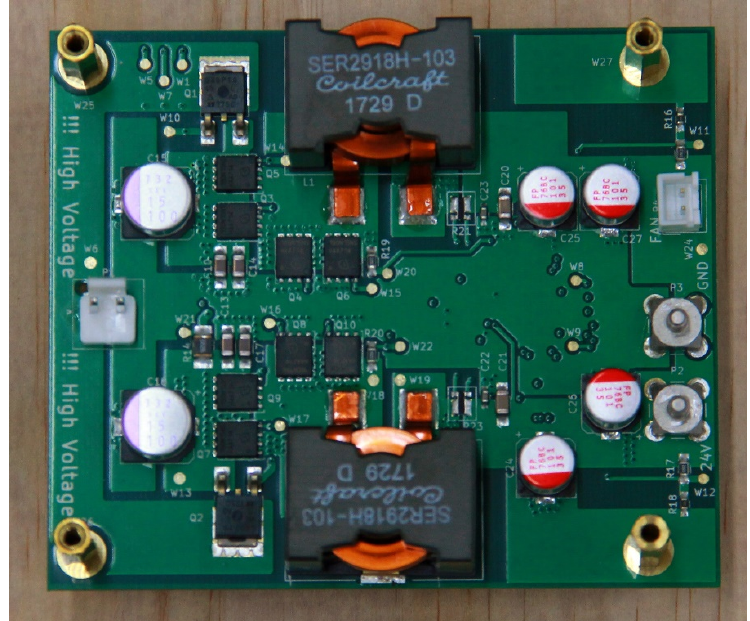
Figure A2. The photograph of the DC-DC converter’s printed circuit board.